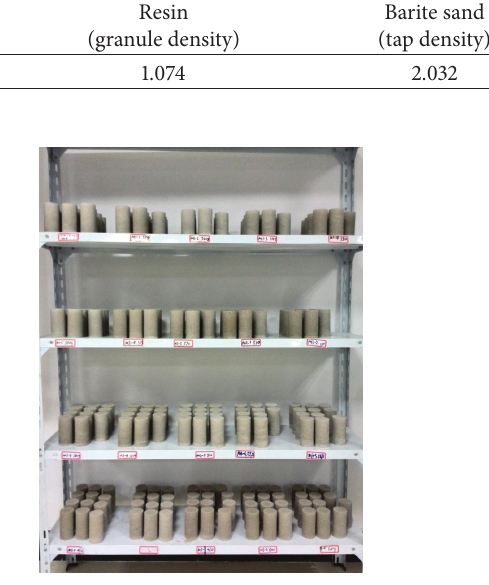
Figure 3: Samples curing in